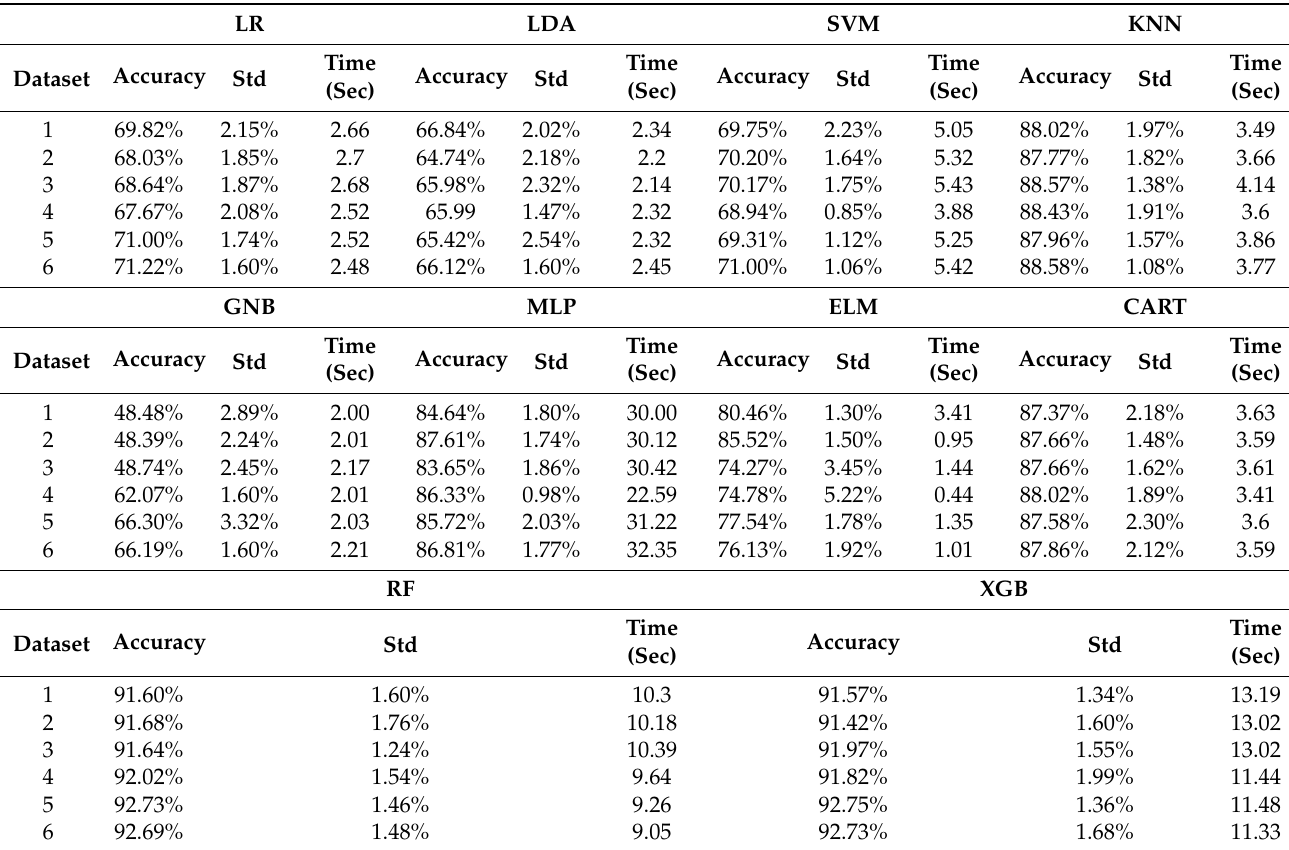
Table 9. Testing results for the first testing stage (LR: Logistic Regression, LDA: Linear Discriminant Analysis, SVM: Support Vector Machine, KNN: K Nearest Neighbor, GNB: Gaussian Naïve Bayes, MLP: Multi-Layer Perceptron, ELM: Extreme Learning Machine, CART: Classification and Regression Trees, RF: Random Forest, XGB: xGBoost, std: standard